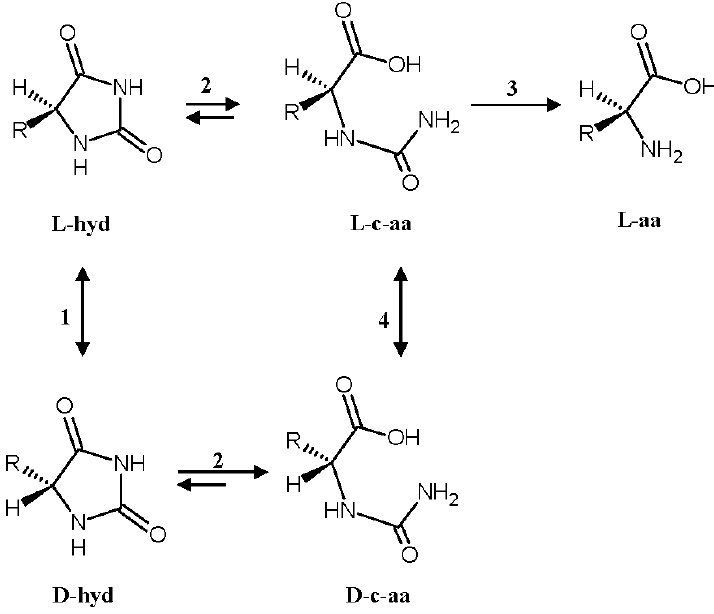
Figure 1. Reaction scheme of the so ‐ called “double ‐ racemase hydantoinase process” for optically pure L ‐ amino acid production. (1) Hydantoin racemase. (2) D , L ‐ Hydantoinase. (3) L ‐ Carbamoylase. pure L -amino acid production. (1) Hydantoin racemase. (2) D , L -Hydantoinase. (3) L